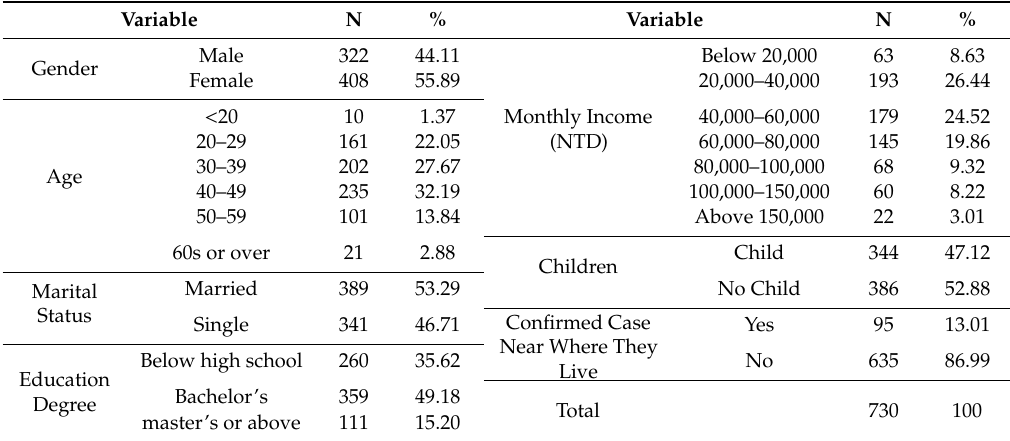
Table 3. Demographic characteristics of respondents.